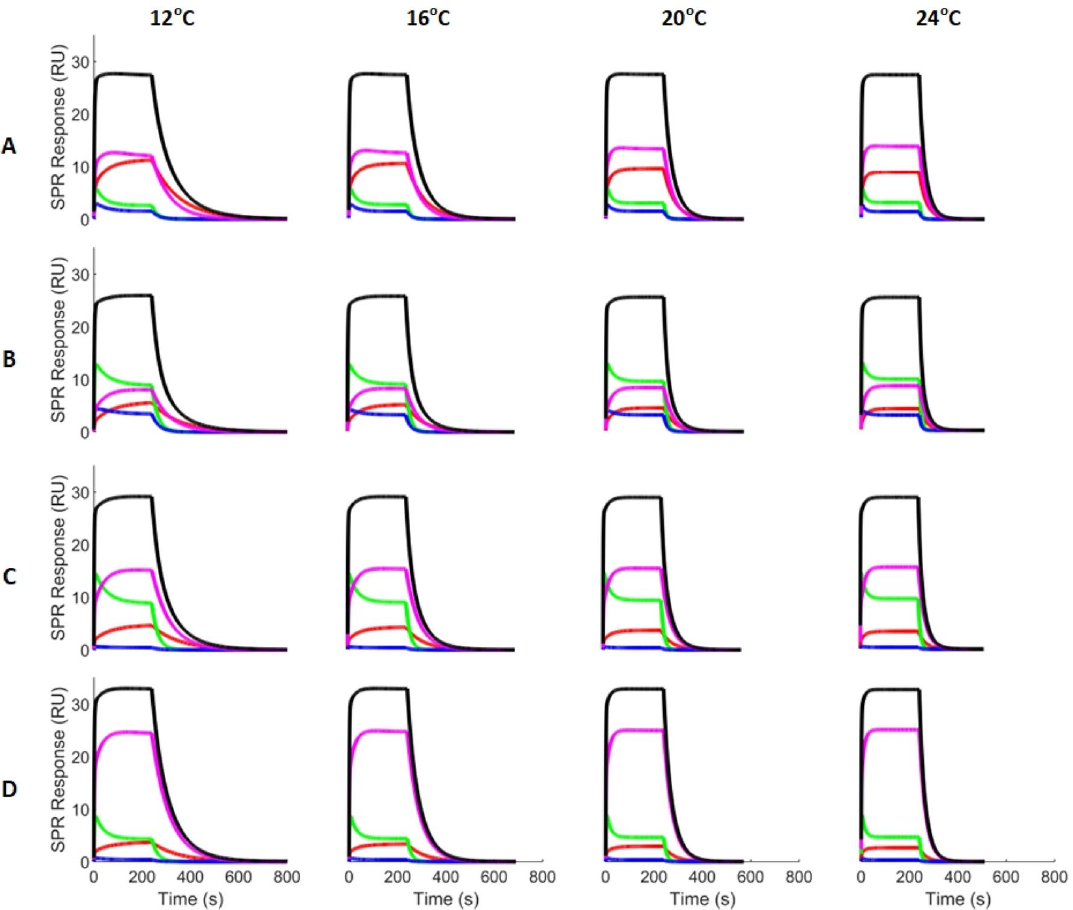
Figure 3. Kinetic analysis of the contribution of CBS (red), BDS (green), sulfanilamide (blue) and furosemide (magenta) to the SPR response of each mixture (see Table 1) at each temperature. The kinetic parameters identified with classical single-analyte experiments were used to generate this figure. The summation of these signals gives the predicted signal (black). Only the responses corresponding to the maximal concentration (22 400 nM) are